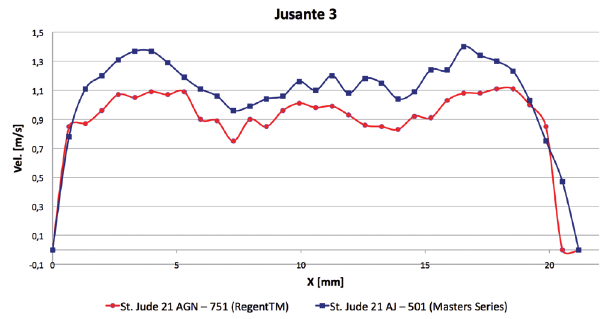
Fig. 8 - Velocity profiles at 32 mm downstream of the